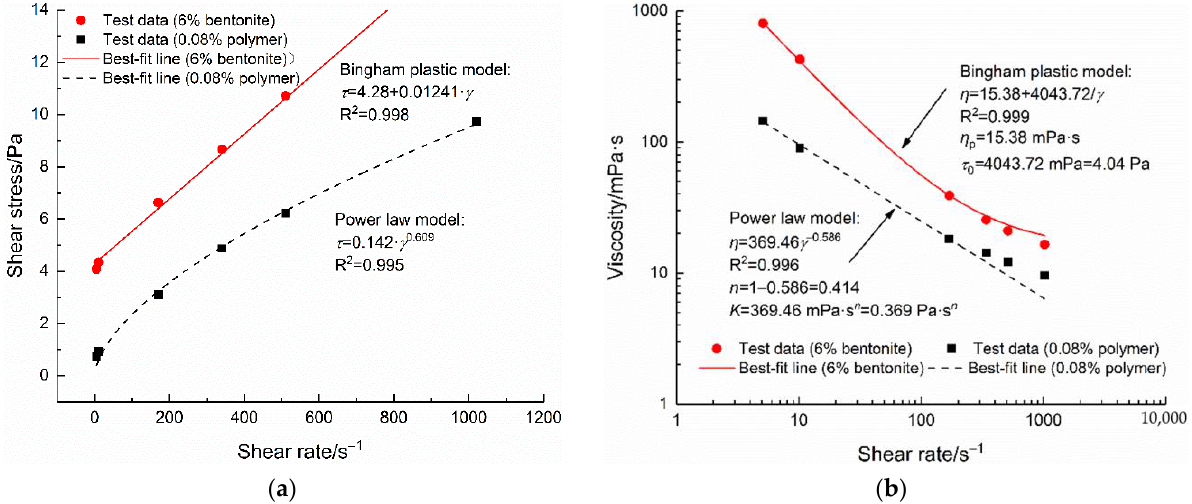
Figure 3. Rheological properties of 6% bentonite and 0.08% polymer fluids: ( a ) shear stress-shear rate relationship; ( b ) apparent viscosity-shear rate relationship.